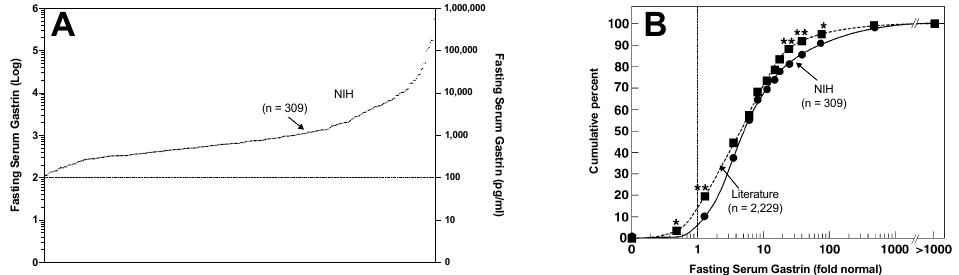
Figure 1. Fasting serum gastrin (FSG) concentration in Zollinger–Ellison syndrome (ZES) patients at NIH ( n = 309) ( A , B ) and from the literature ( n = 2229) ( B ). In ( A ), the FSG is expressed as log of concentration (left Y axis) with the numerical value in pg / mL (right Y axis), with upper limit of normal shown by the dotted line. In ( B ), the FSG levels from both the NIH and from literature patients are shown as fold over normal with normal FSG level indicated by the dotted line. Asterisks indicated statistically significant di ff erences ( p < 0.02) in two groups of patients for a given FSG level in ( B ). Figure is drawn from data in [24]. Note that 40% of ZES patients have FSG levels that overlap with those seen in non-ZES patients taking chronic proton pump inhibitors (PPIs).